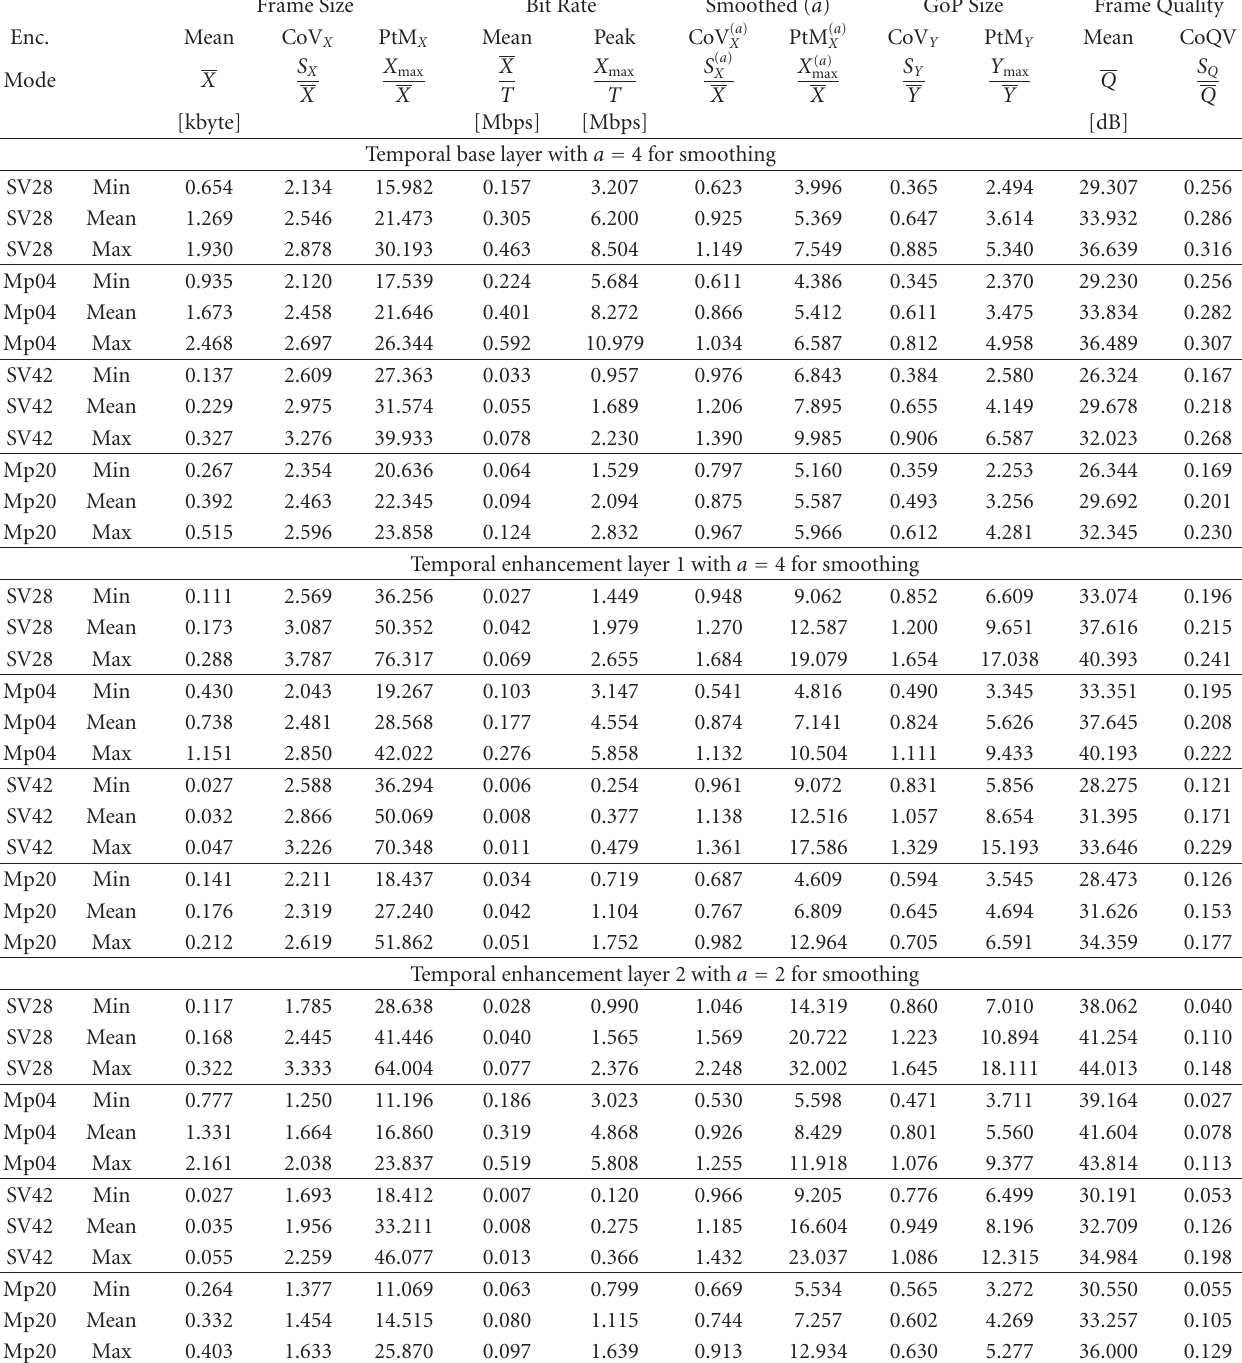
Table 2: Tra ffi c statistics for the layers of temporal scalability encodings using H.264 SVC and MPEG-4 Part 2 for selected quantization scales with GoP structure